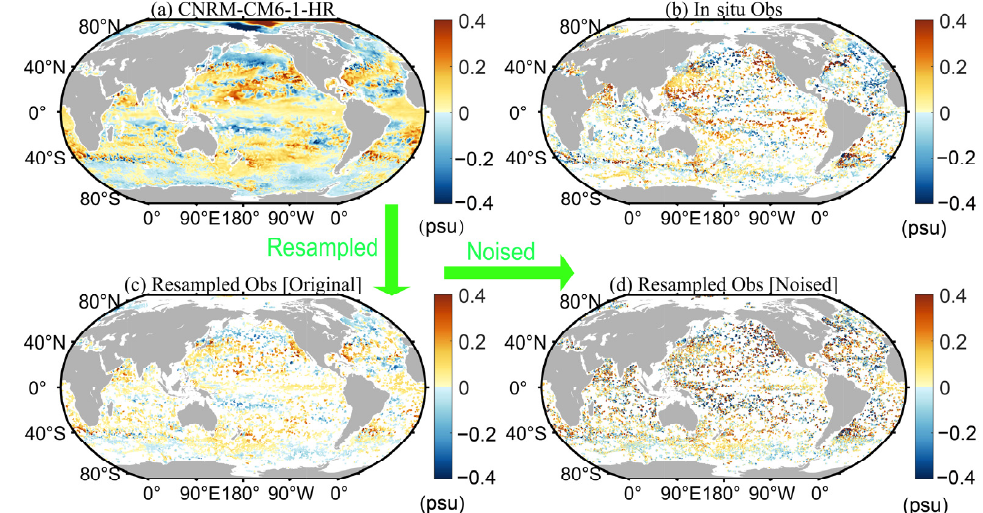
Figure 1. Examples of the resampled data at 100 m depth for January 2016. ( a ) Salinity anomaly field of the CNRM-CM6-1-HR model. ( b ) In situ observations of salinity. ( c ) Salinity anomaly field resampled according to the location of in situ observations. ( d ) Noised resampled salinity anomaly